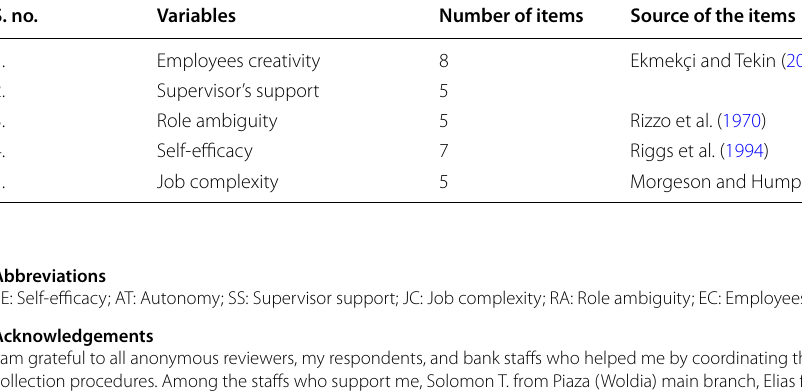
Table 7 List of variables, number of items and sources of the items S.